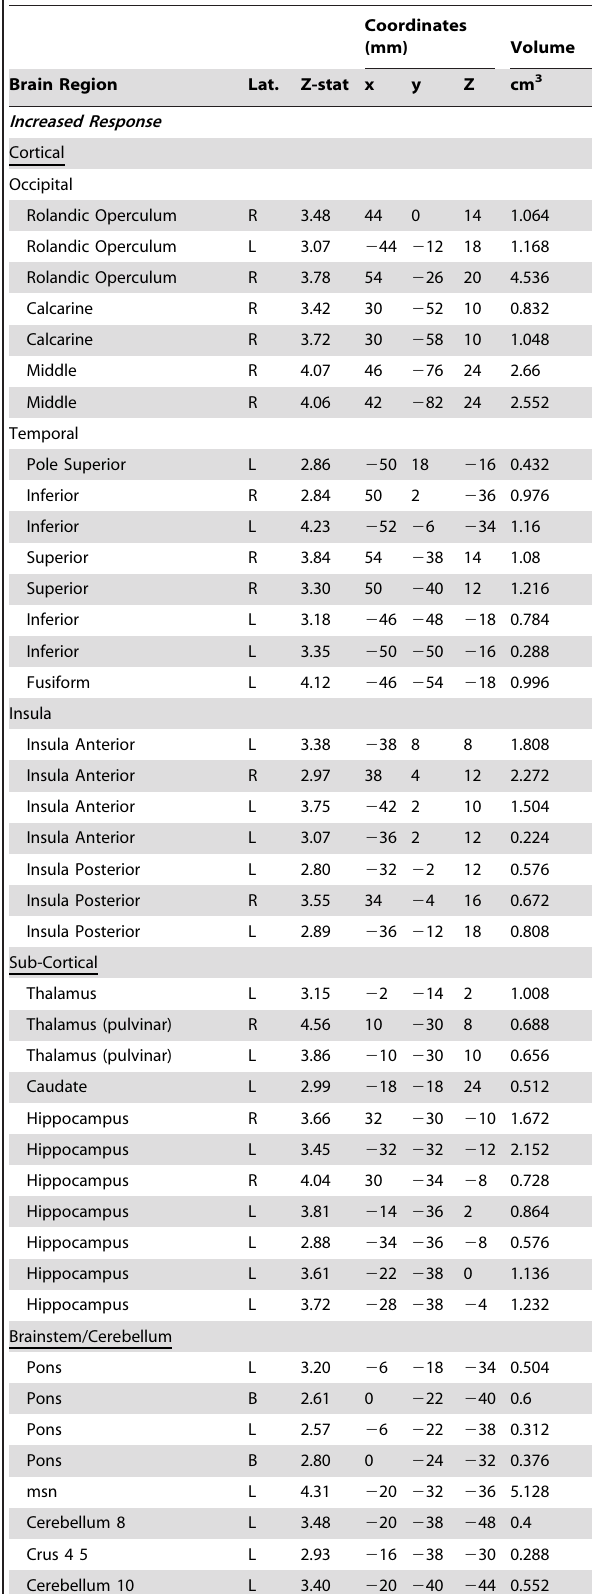
Table 1. Nalb-Sal-induced changes in BOLD activity.